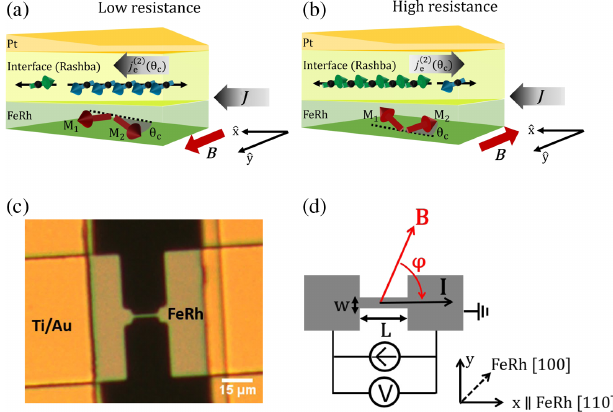
FIG. 1. UMR effect in canted antiferromagnet and sample layout. (a),(b) Rashba-effect-induced nonlinear charge current j ð 2 Þ ð θ Þ at the antiferromagnet/heavy-metal interface for J k ˆ x e c ð J k − ˆ x Þ at large field B . The green and blue arrows in (a) and (b) indicate the direction of the spin polarizations. Resistance is ð 2 Þ ð θ Þ is aligned (antialigned) with J . low (high) when j e c (c) Optical microscope image of a FeRh = Pt microwire device. (d) Schematic of the longitudinal resistance measurements. A large dc current of the order of 10 7 A = cm 2 is applied to induce a UMR, while a small ac current is applied to perform the lock-in amplifier measurement. The angle φ is defined as the clockwise angle from the field B to current I , where I ¼ I ˆ x